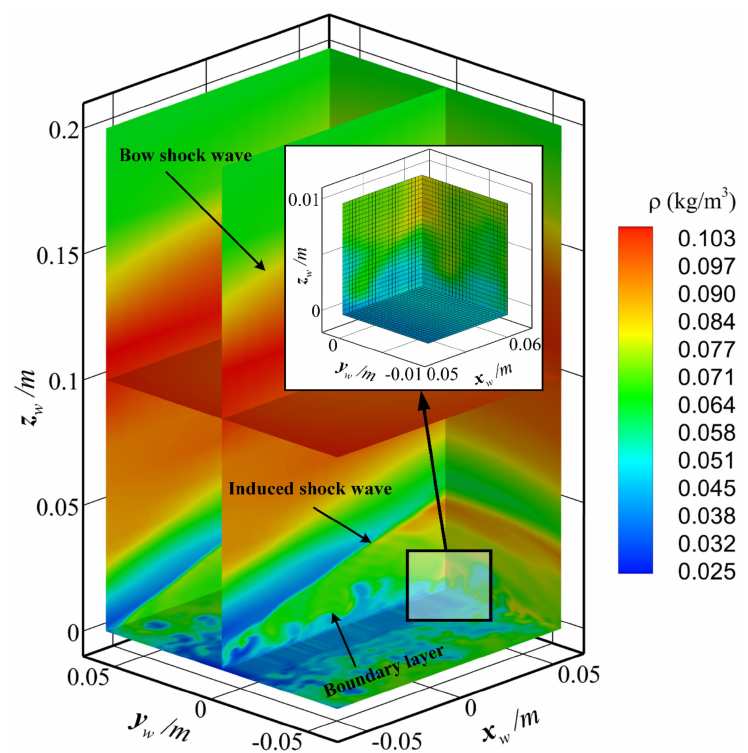
Figure 11. Optical simulation threshold above the window and its spatial structure